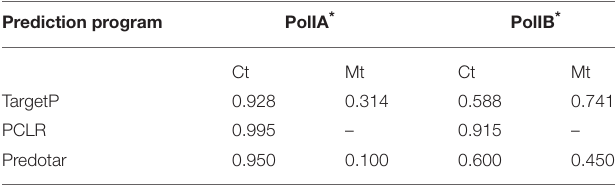
TABLE 1 | Prediction of PolIA and PolIB organelle